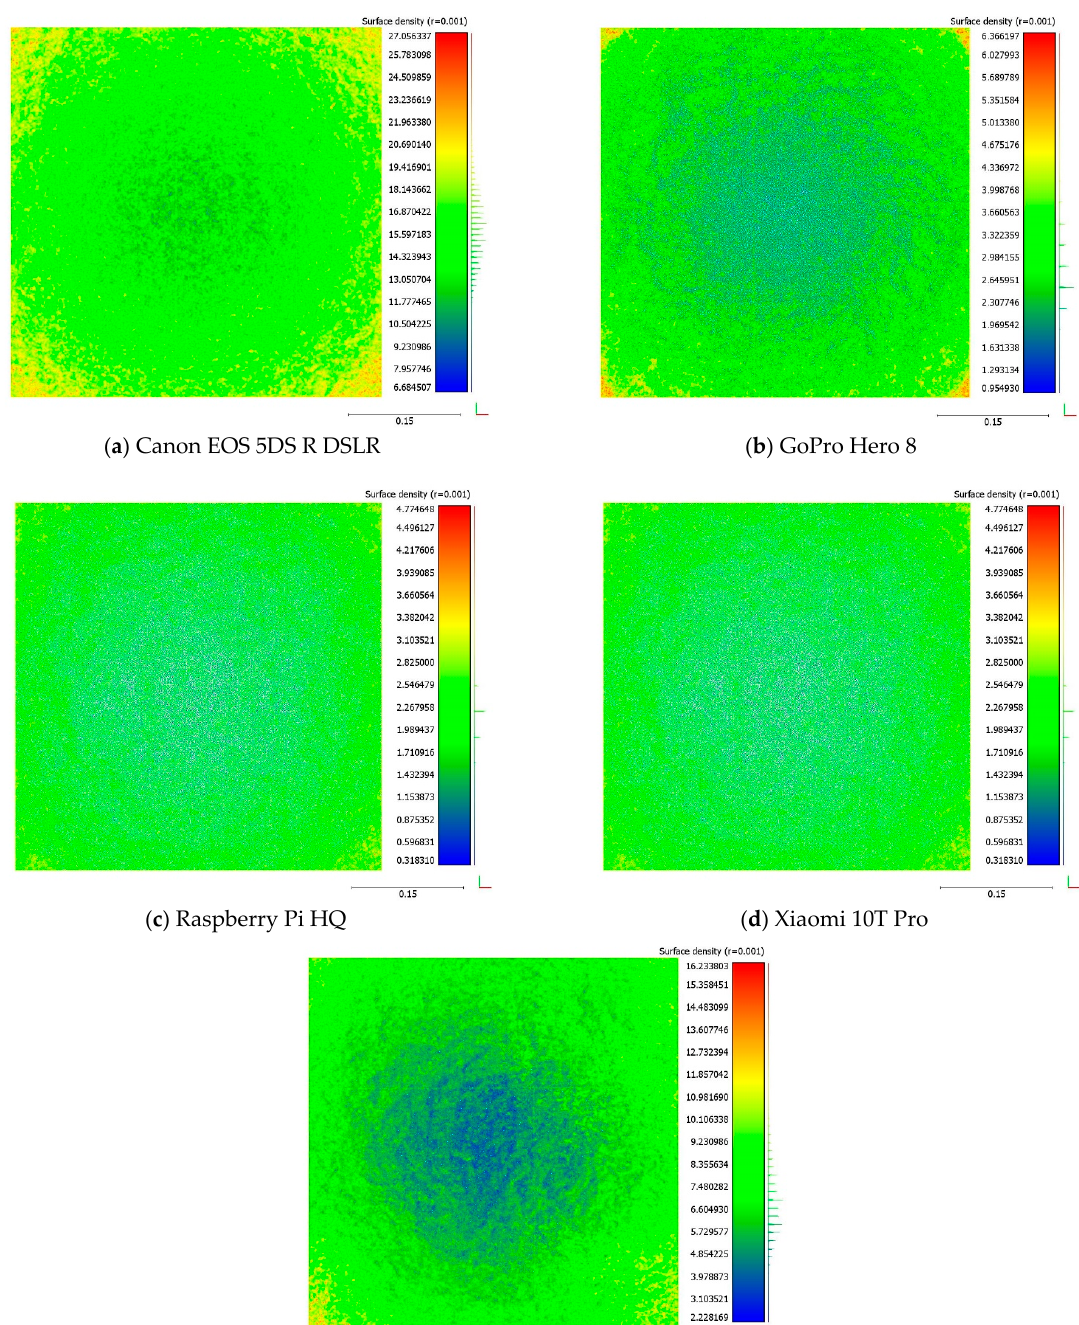
Figure 7. Surface density of the bottom surface in the 3D models.